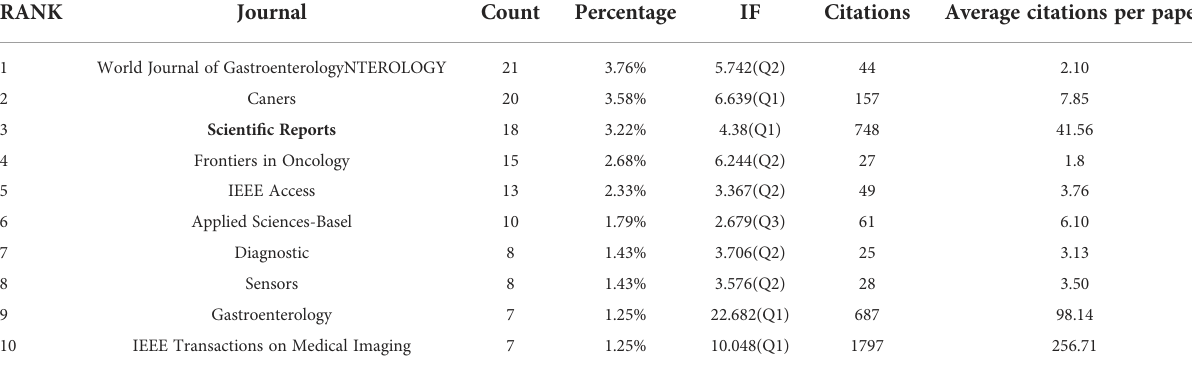
TABLE 4 Top 10 of most productive